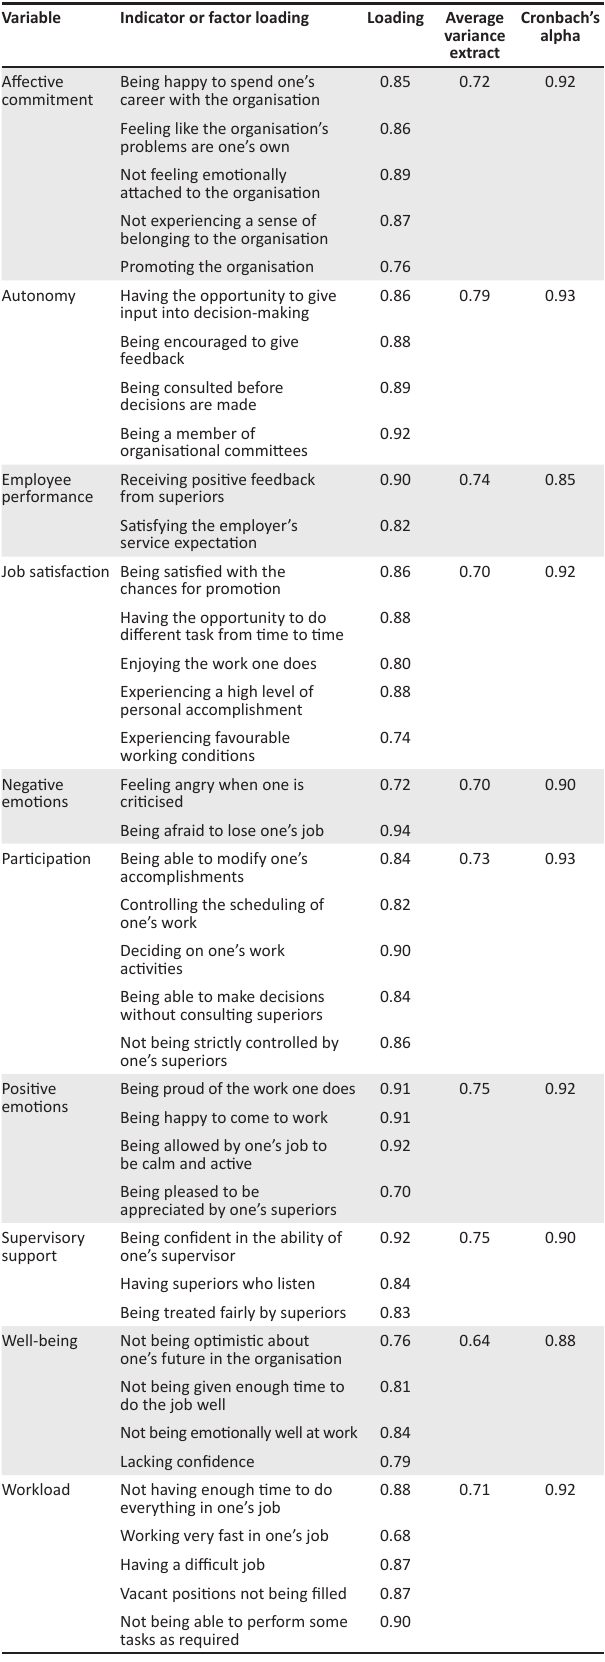
TABLE 3: Measurement